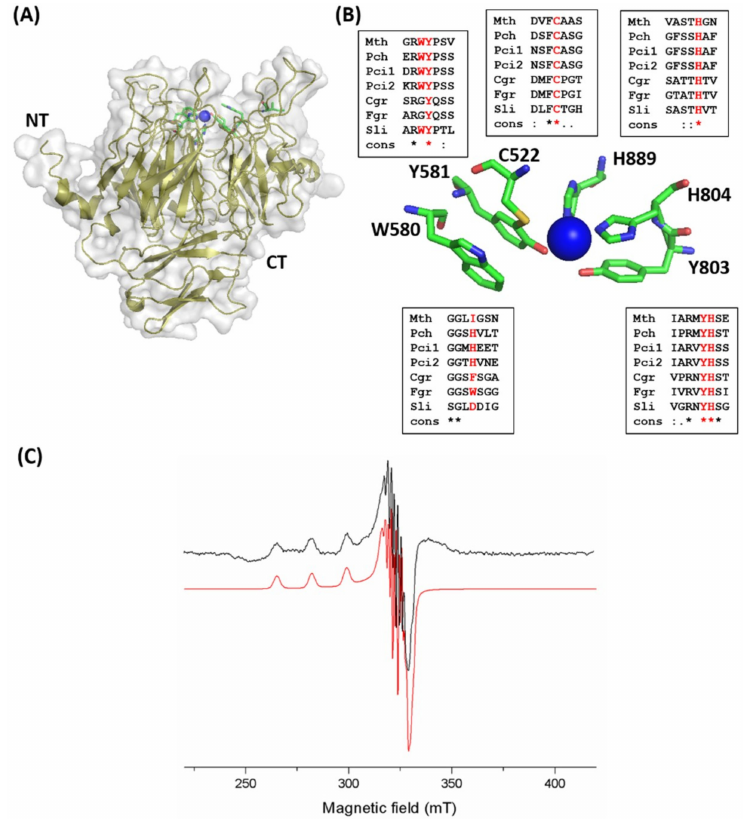
Figure 4. Structural model and spectroscopy of the Mt GLOx Cu center. ( A ) Cartoon representation of the model of the catalytic domain of Mt GLOx. ( B ) Stick model of the substrate pocket showing the conserved residues coordinating the copper ion (blue sphere). Sections of the sequence from the characterized glyoxal oxidases from P. chrysosporium (Pch) and Pycnoporus cinnabarinus (Pci1 and 2), alcohol oxidase from Colletotrichum graminicola (Cgr), galactose oxidase from Fusarium graminearum (Fgr) and cuproenzyme from Streptomyces lividans (Sli) showing conserved amino acids. ( C ) Cu(II)- Mt GLOx EPR spectrum (black) with simulation